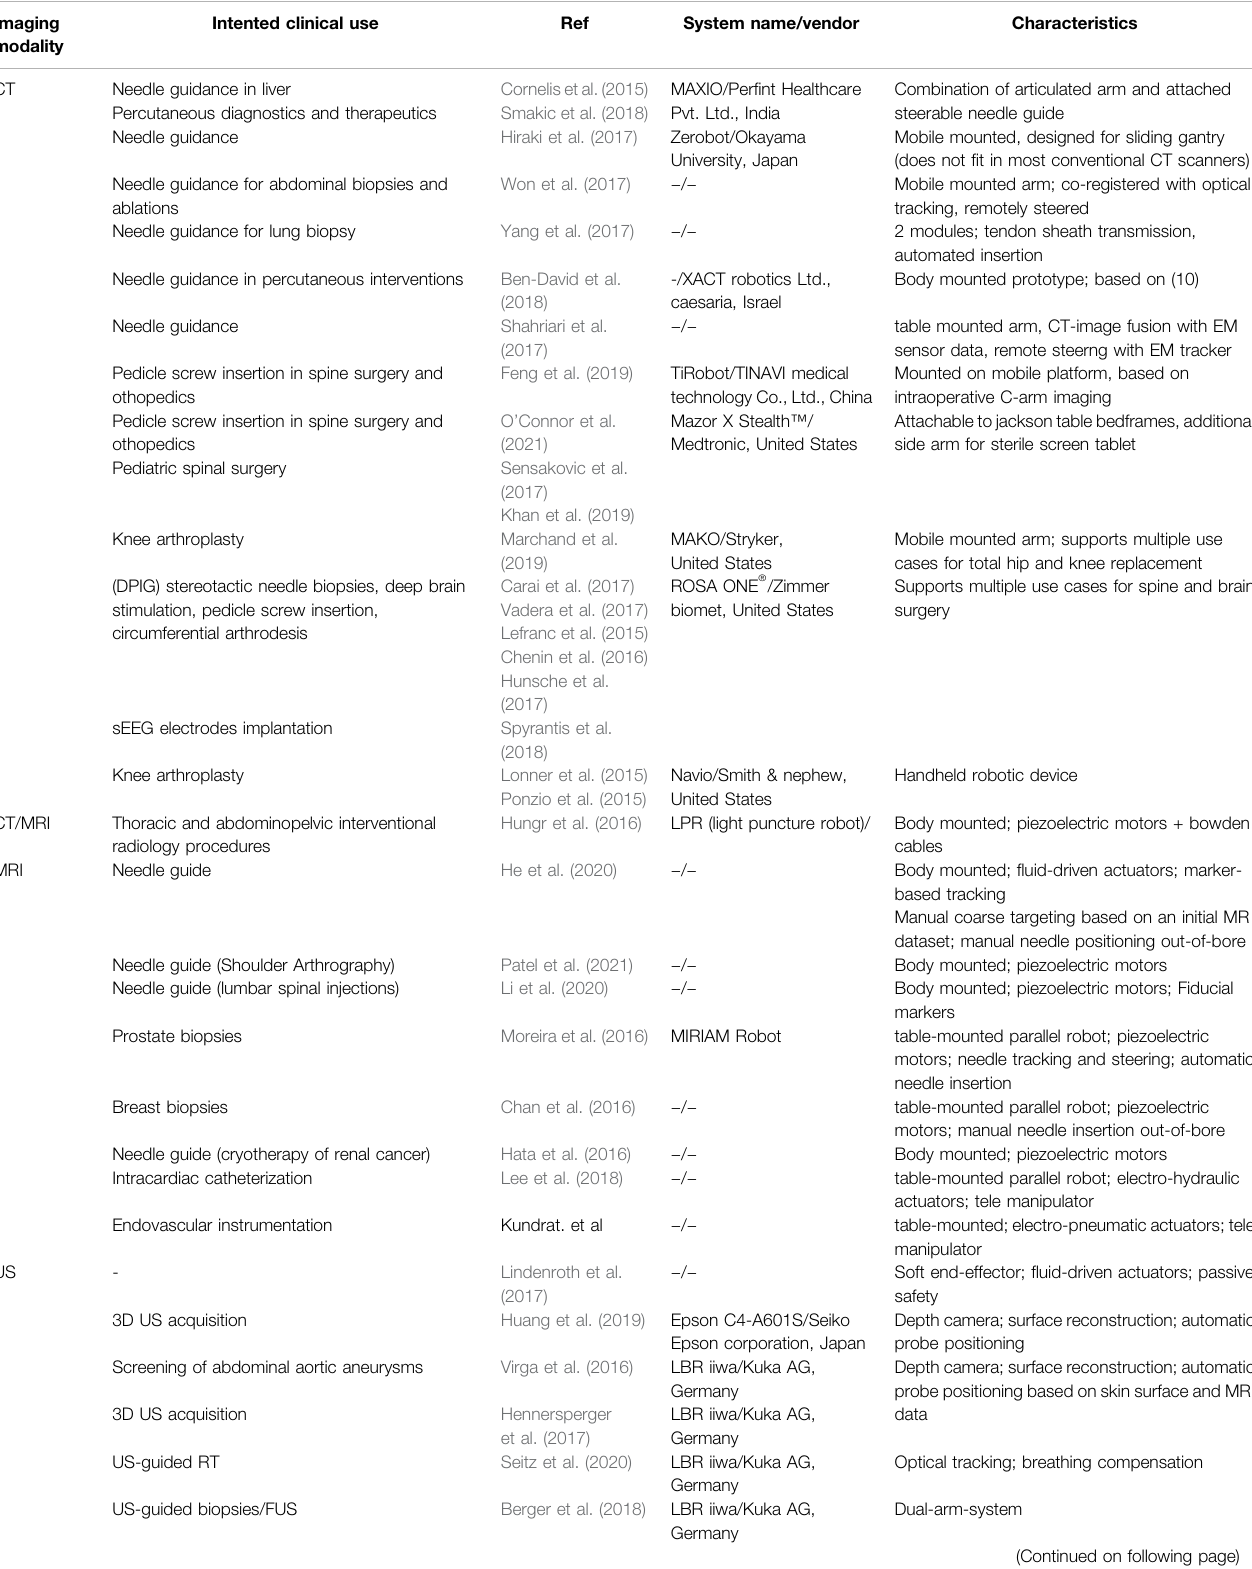
TABLE 1 | Overview of the reported systems. Imaging modality